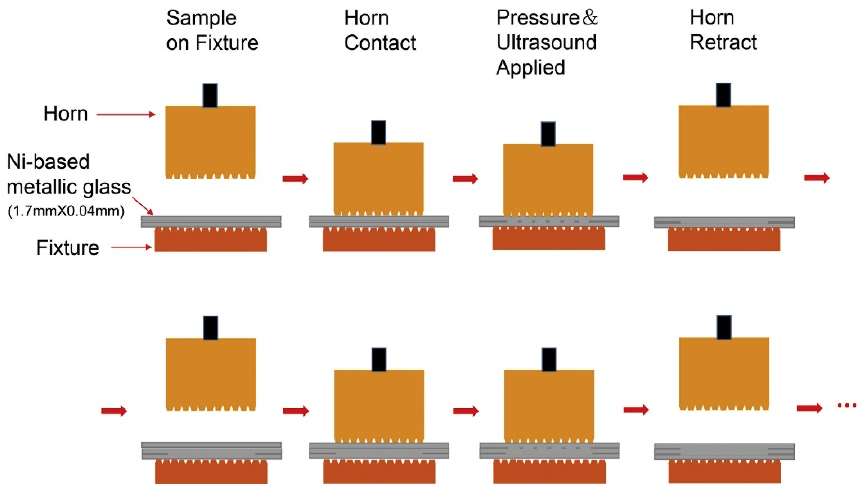
Figure 11. Schematic illustration of the UAM process. Reproduced from [115], with permission from Elsevier, 2021.